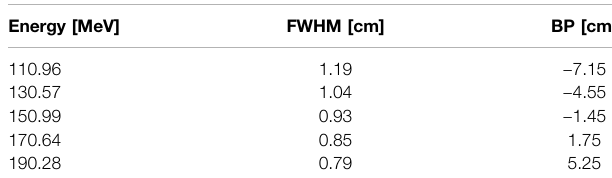
TABLE 1 | Proton beam parameters of the MC simulations used to build the calibration: beam energy, full width at half maximum, and theoretical Bragg peak position. The error on the BP is 0.03 cm, from the fi nite binning of the obtained dose